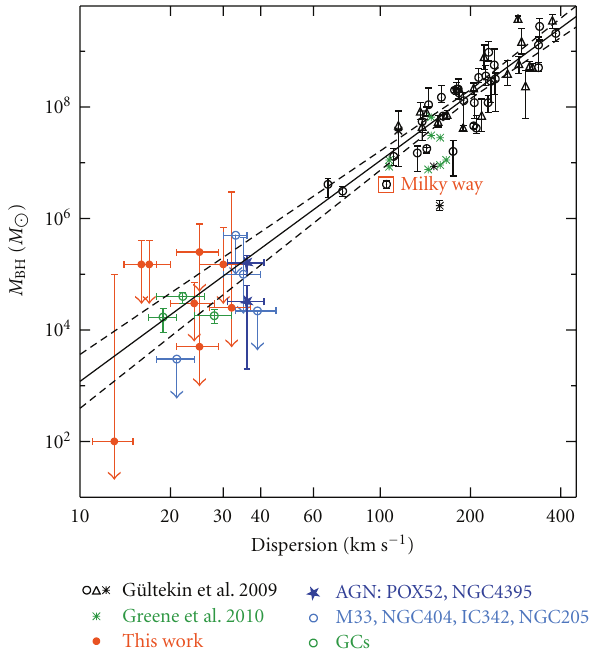
Figure 2: The relation between the mass of the BH and the velocity dispersion of the spheroid around it. We plot the objects as listed in the text. The lines give the best fit of G¨ultekin et al. [58]. Graham and Driver [33] (filled black circles), while the other data points come from the same sources as in Figure 2.